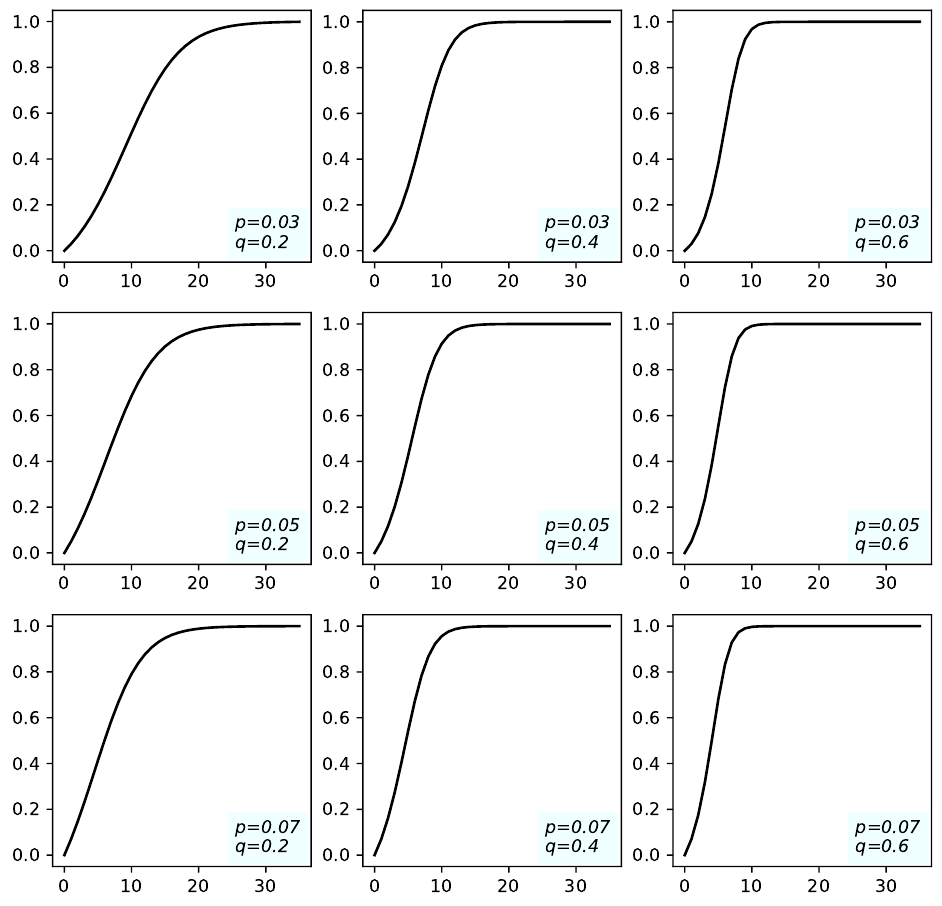
Figure 3. The impact of p and q on the S-shaped diffusion pattern; the horizontal axes indicate time (years); vertical axes indicate market